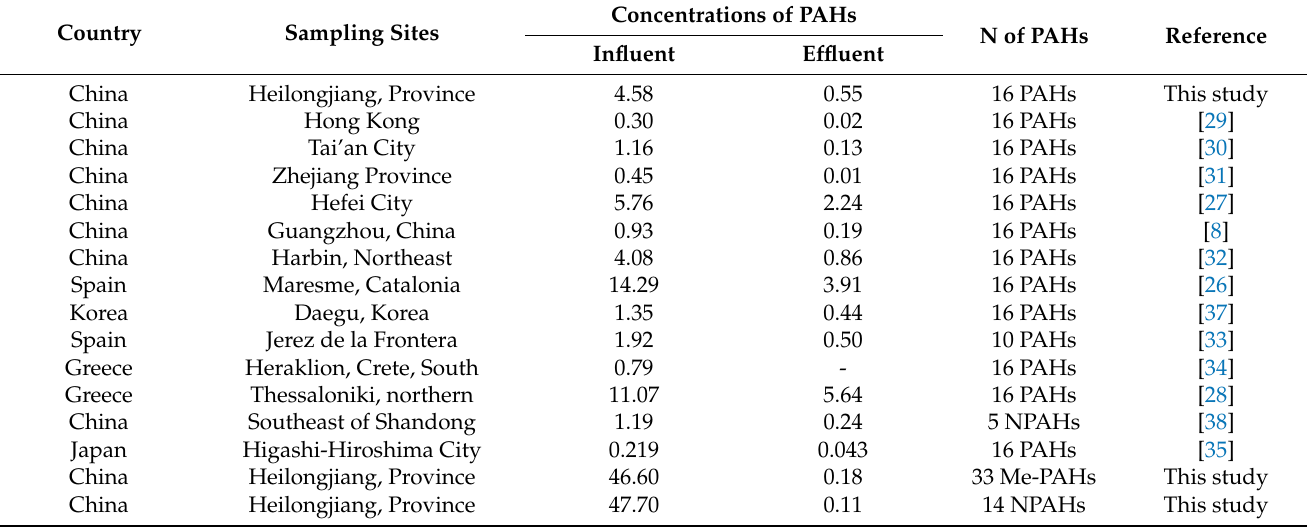
Table 2. The concentrations ( µ g/L) of the target compounds of different places worldwide. Sampling